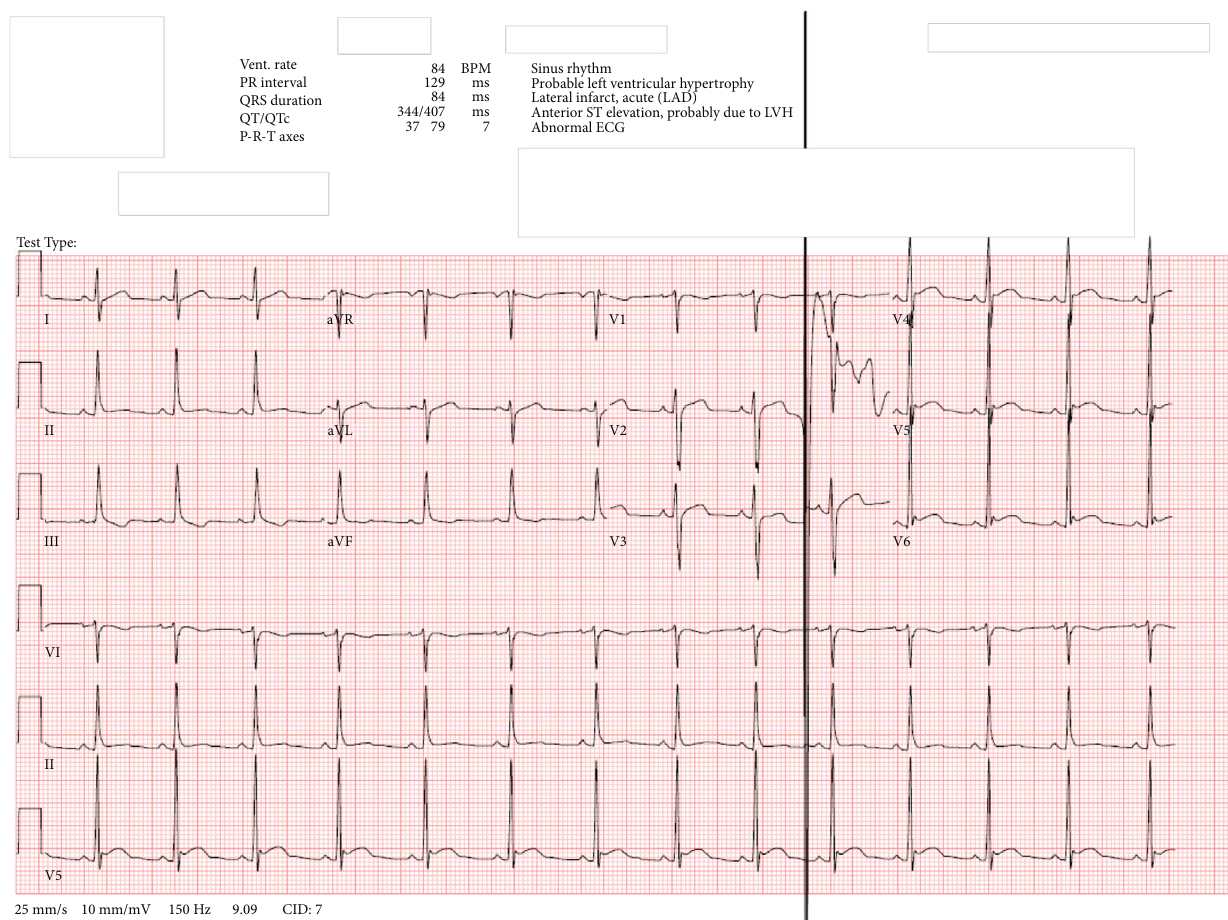
Figure 2: EKG from hospital day